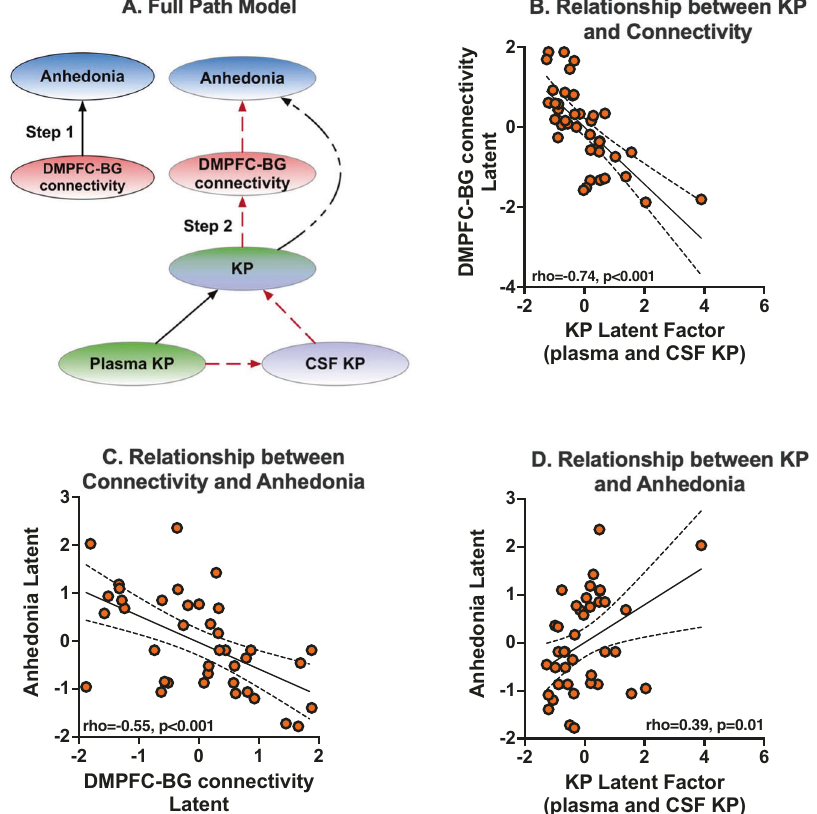
Fig. 4 Connectivity-anhedonia associations. A presents the overall scheme of the path model between all the latent factors within a single, re fl ective, multilevel path model. Brie fl y, kynurenine (KYN) and 3-hydroxykynurenine (3HK) in plasma and CSF were loaded onto their respective plasma and CSF kynurenine pathway (KP) factors that loaded further onto a combined KP factor. The KP factor was then related to the dorsomedial prefrontal (DMPFC)-basal ganglia (BG) latent factor that was further linked to the anhedonia latent factor described earlier. DMPFC-BG latent factor was composed of both plasma and CSF connectivities selected based on factor loadings (loading coef fi cient > 0.7). Three of 4 of the above connectivities, DMPFC-DMPFC (right to left DMPFC), DMPFC-left ventrolateral prefrontal region (LVLPFC), DMPFC-left dorsolateral prefrontal region (DLPFC), were correlated with plasma KYN, and 1/4, i.e., DMPFC-left basal ganglia (LBG) was correlated with CSF 3HK. The red-colored broken lines represent direct paths that combined to create an indirect or mediation effect. Step 1 ( A ) examined a direct relationship between functional connectivity and anhedonia. B – D represents linear associations between the latent factor scores, with the relationship expressed as Spearman rho values. B represents the direct association between KP and DMPFC-BG connectivity (rho = 0.74, p < 0.001), and C presents the direct association between DMPFC-BG connectivity and anhedonia (rho = 0.55, p < 0.001). D represents the indirect association between KP and anhedonia mediated by DMPFC-BG connectivity (rho = 0.39, p < 0.01). A mediation effect of the link between KP and anhedonia by connectivity and the relationship between plasma KP and anhedonia by CSF KP and connectivity was signi fi cant (details in